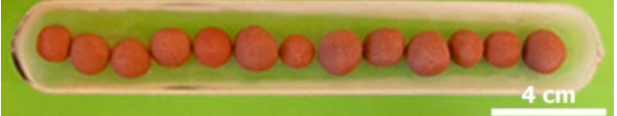
Figure 1. Optical image of the (hematite + W-PVC + clay) pellets mixtures. Experiments to study the thermal behavior of the various samples and their mixtures were performed in the simple experimental setup sketched in Figure 2. The main equipment